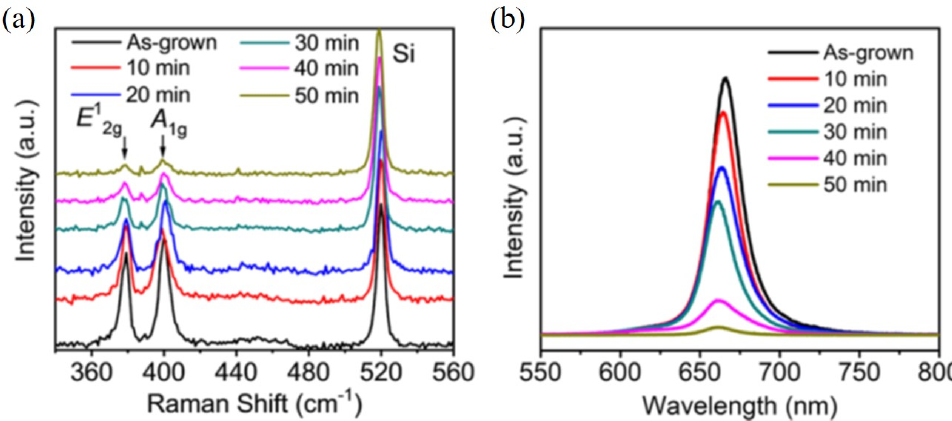
Figure 4. ( a ) Raman and ( b ) PL characteristics of MoS 2 with varying N 2 plasma treatment time [42].